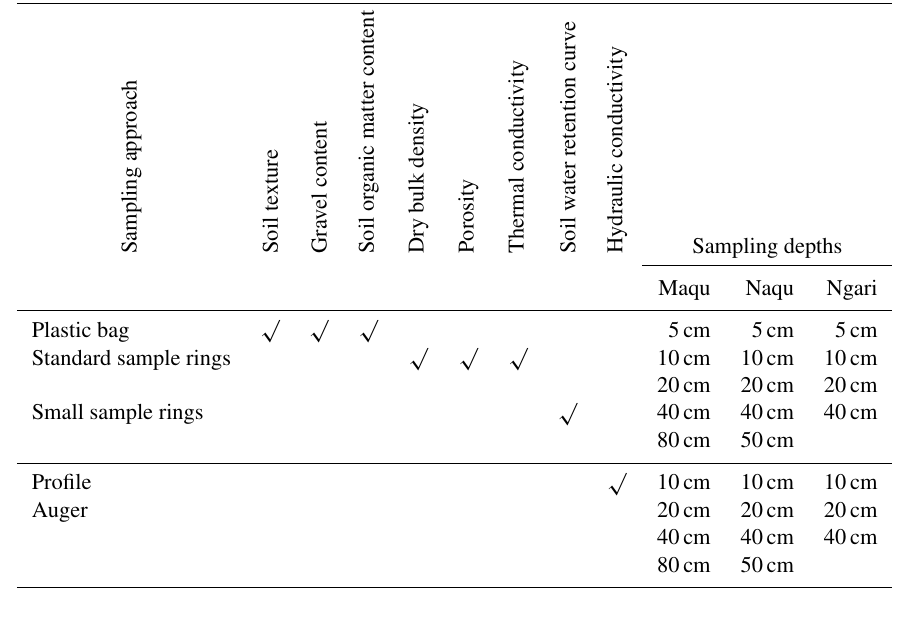
Table 1. Sampling approach for soil basic properties, SHP and STP over the